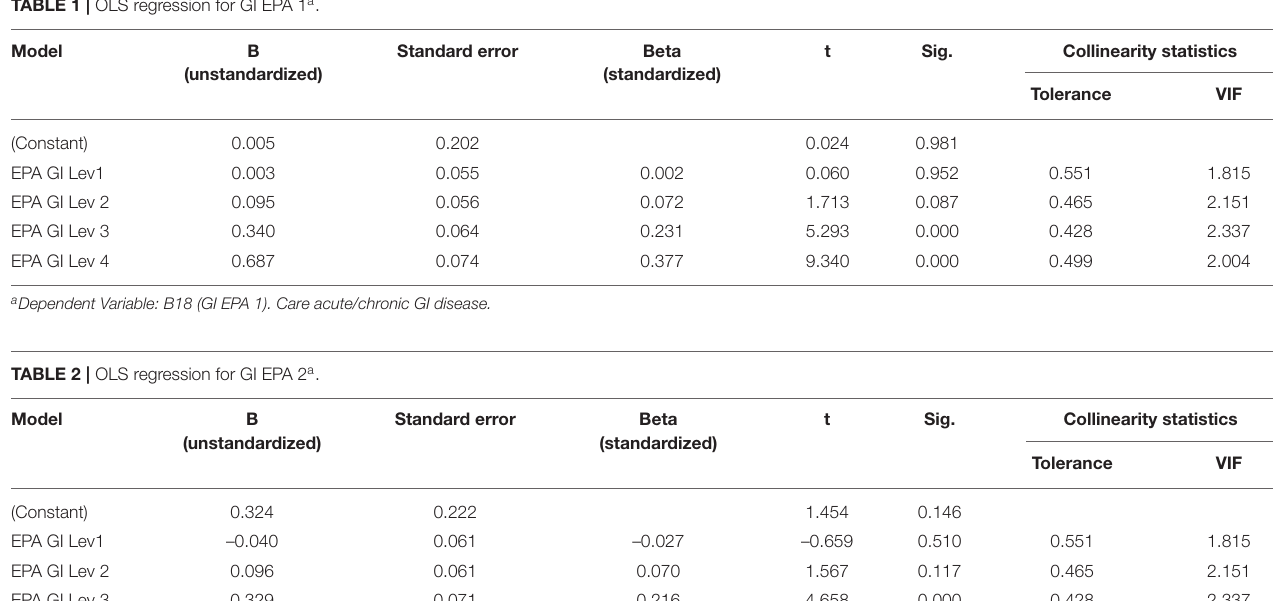
TABLE 1 | OLS regression for GI EPA 1 a .